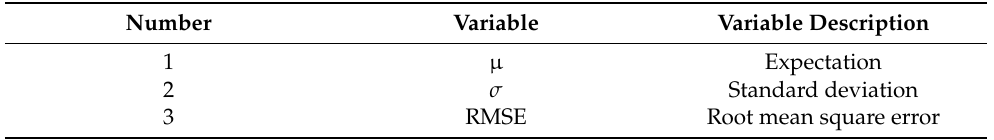
Table 1. Description of the